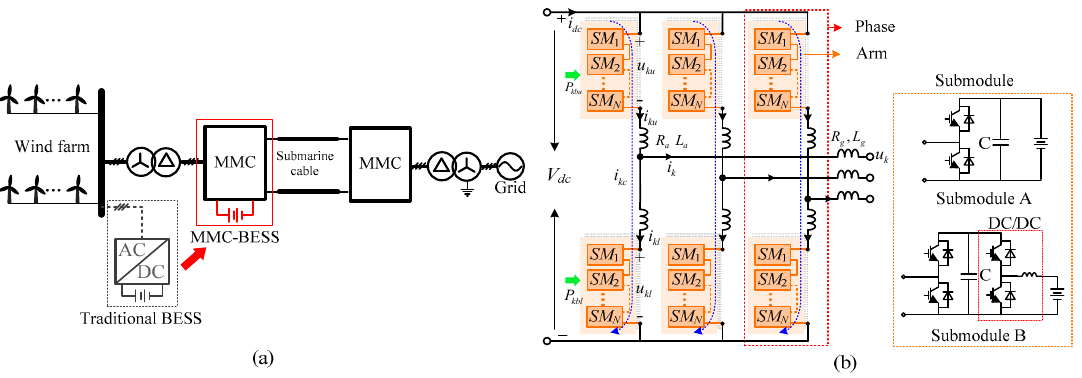
Figure 1. Wind energy generation system: ( a ) structure of offshore wind farm; ( b ) topology of MMC ‐ BESS.